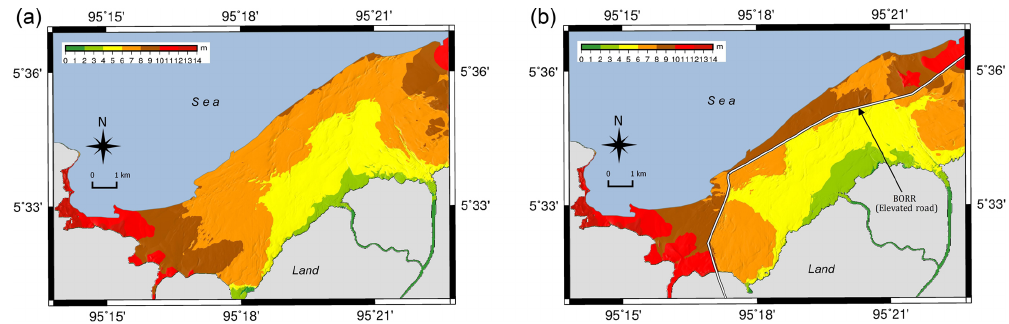
Figure 10. Maximum tsunami wave depths based on the 9.15 M w earthquake without BORR (a) and with BORR (b) . The simulations are shown for the land use type before the 2004 Indian Ocean tsunami.